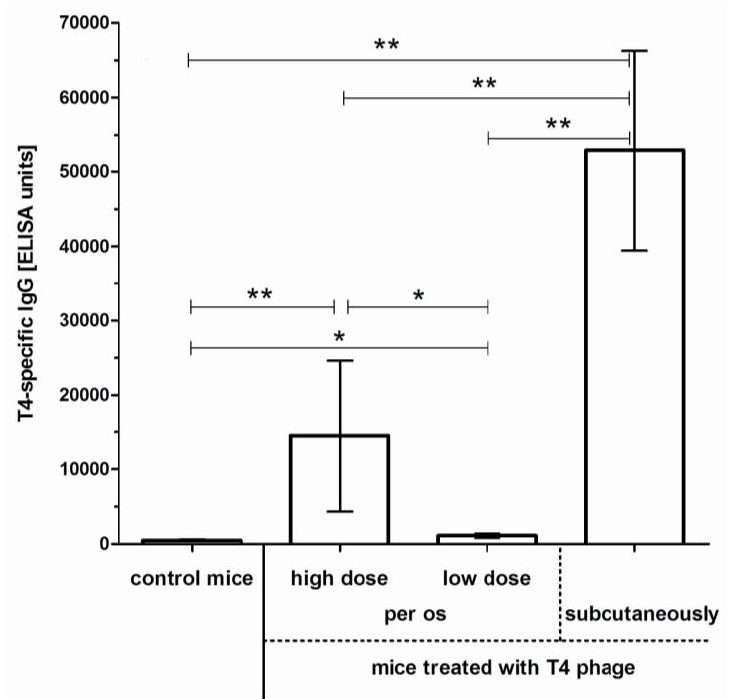
Figure 2. Intensity of anti-T4 phage IgG induction in mice treated with the phage per os and subcutaneously . Mice ( N = 6 or 7) were fed with T4 phage in drinking water for 100